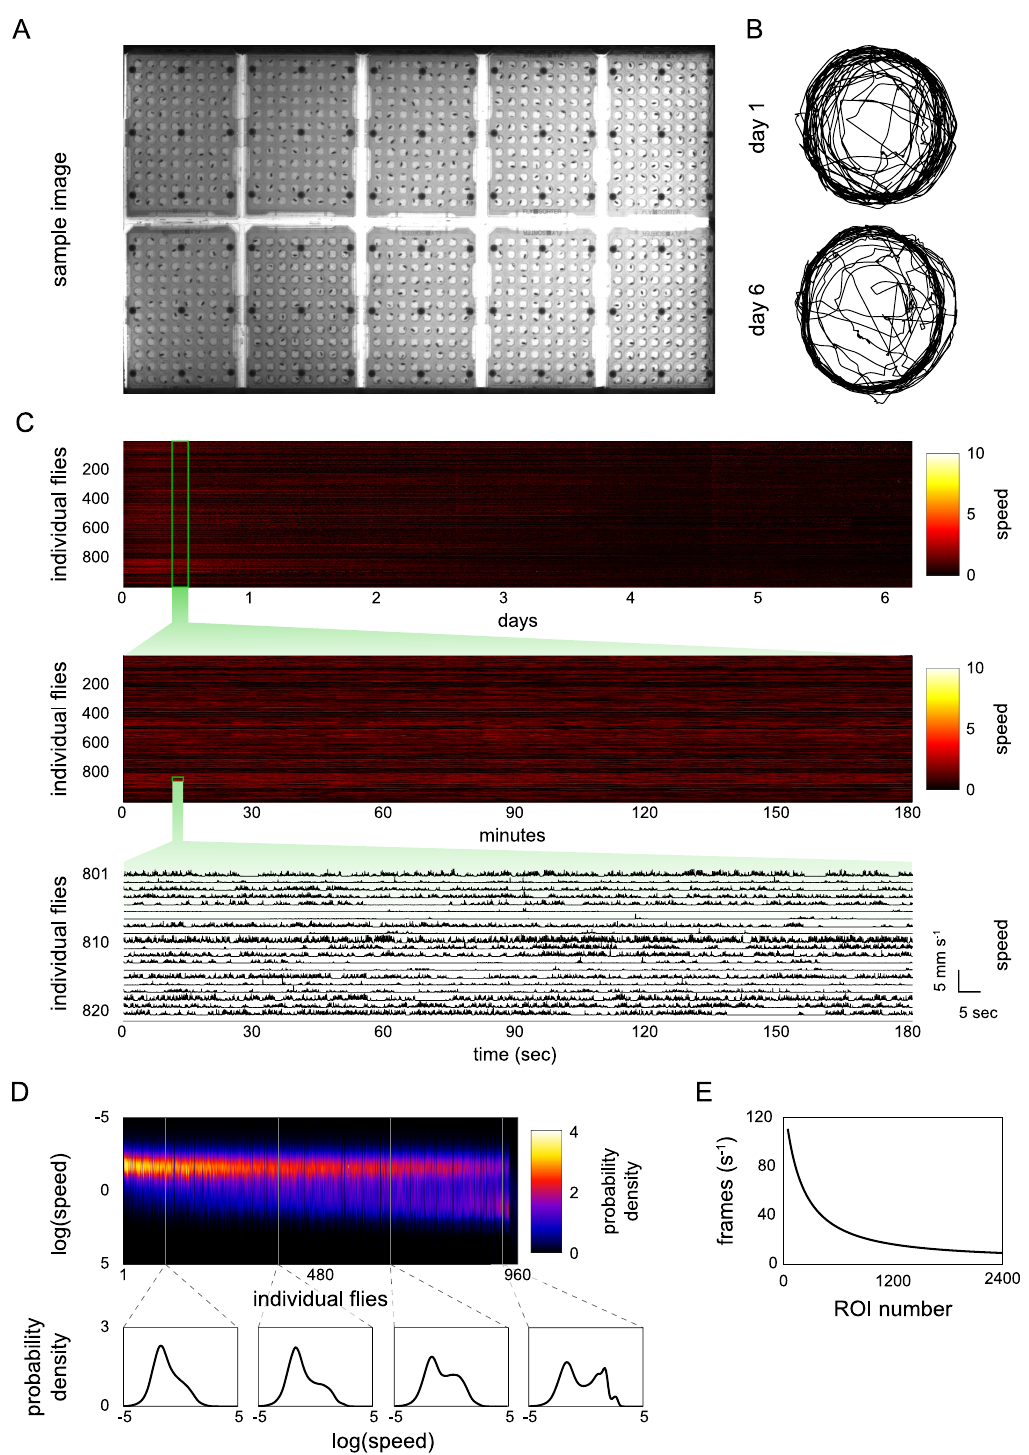
Fig 3. MARGO tracking throughput. A) Image of 10 single-fly housing plates from the overhead tracking camera. B) Sample tracks from the same fly on days 1 and 6. C) Fly speeds at three representative scales: heatmap of individual speed over the duration of the experiment (top), heatmap of individual speed from a three hour period (middle), raw speed traces from twenty individuals from a three minute period (bottom). Activity of most flies decreased over the six day duration. D) Individual kernel density estimates of log speed over the duration of the experiment. Column order was sorted by mean individual bout